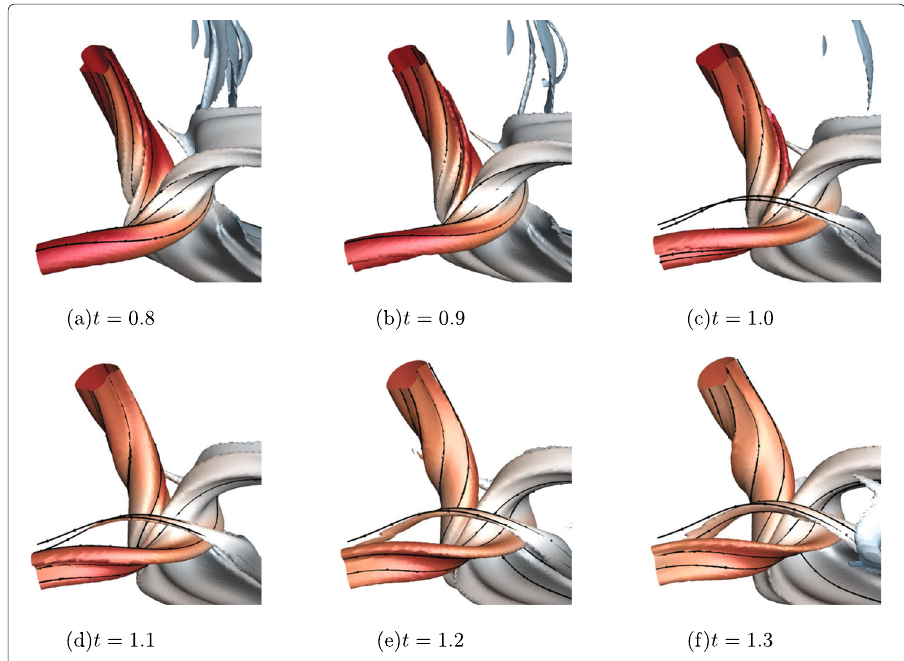
Fig. 11 Further close-up view of the evolution of the VSF isosurface with V φ = V (cid:5) / 16 in the region marked by the red box in Fig. 10 in case M1 ( η M = 0.05). The color bar is the same as that in Fig. 9. Some vortex lines are integrated from points on the